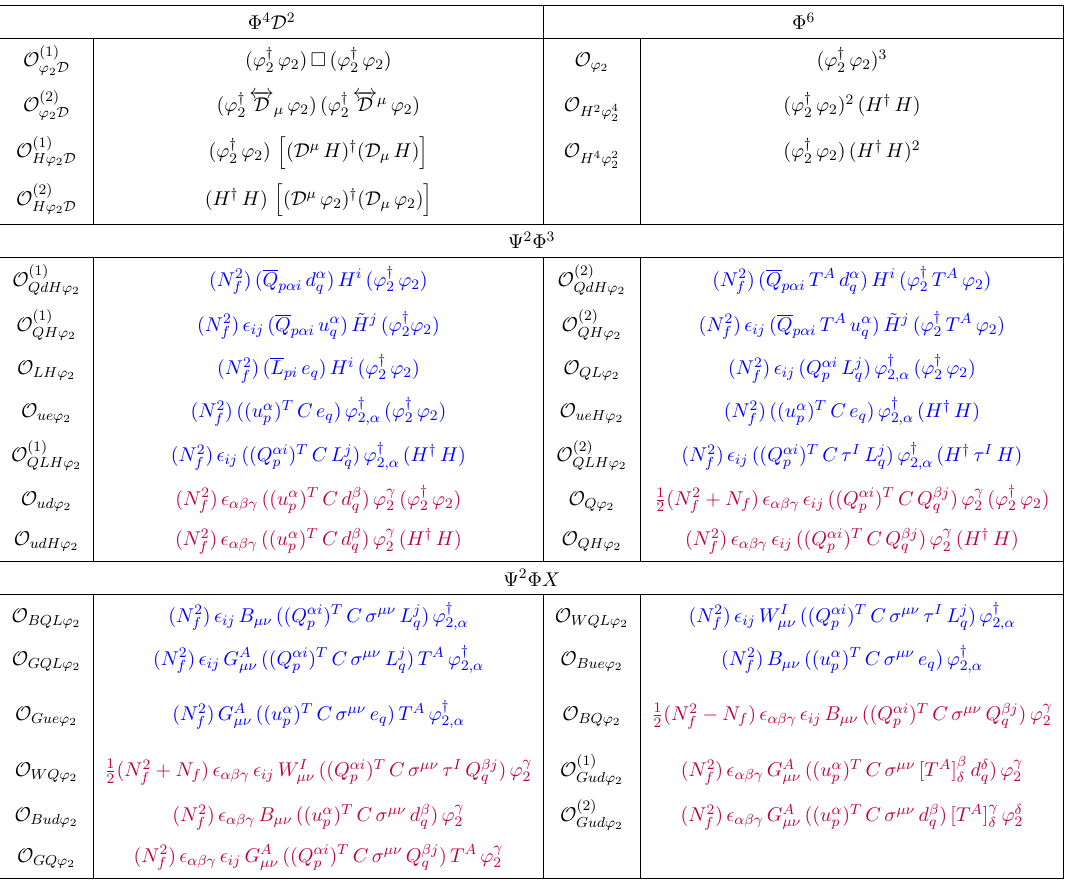
Table 40 . Table 39 continued. Operators in red violate lepton and baryon numbers.